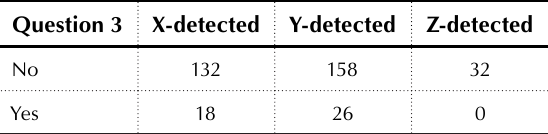
Table 5. The obtained data